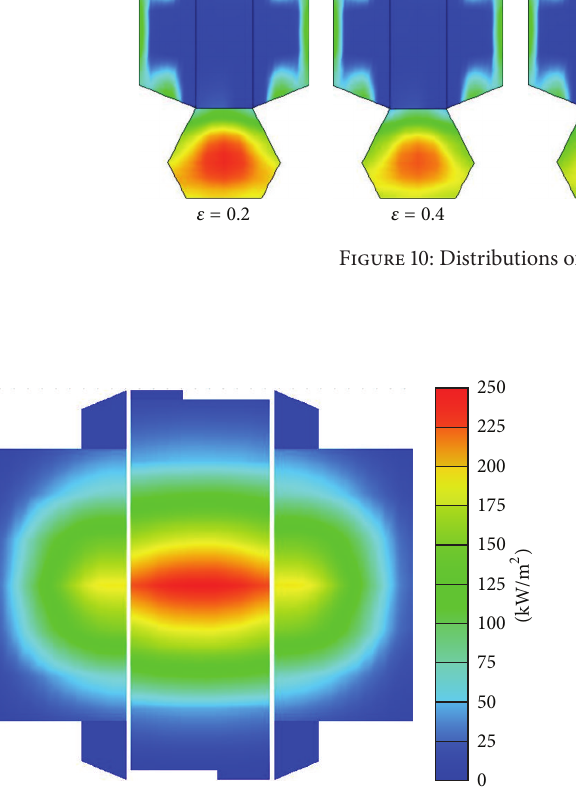
Figure 11: Distribution of heat flux on the absorber panels. Figure 12: Distribution of outer wall temperature of the absorber